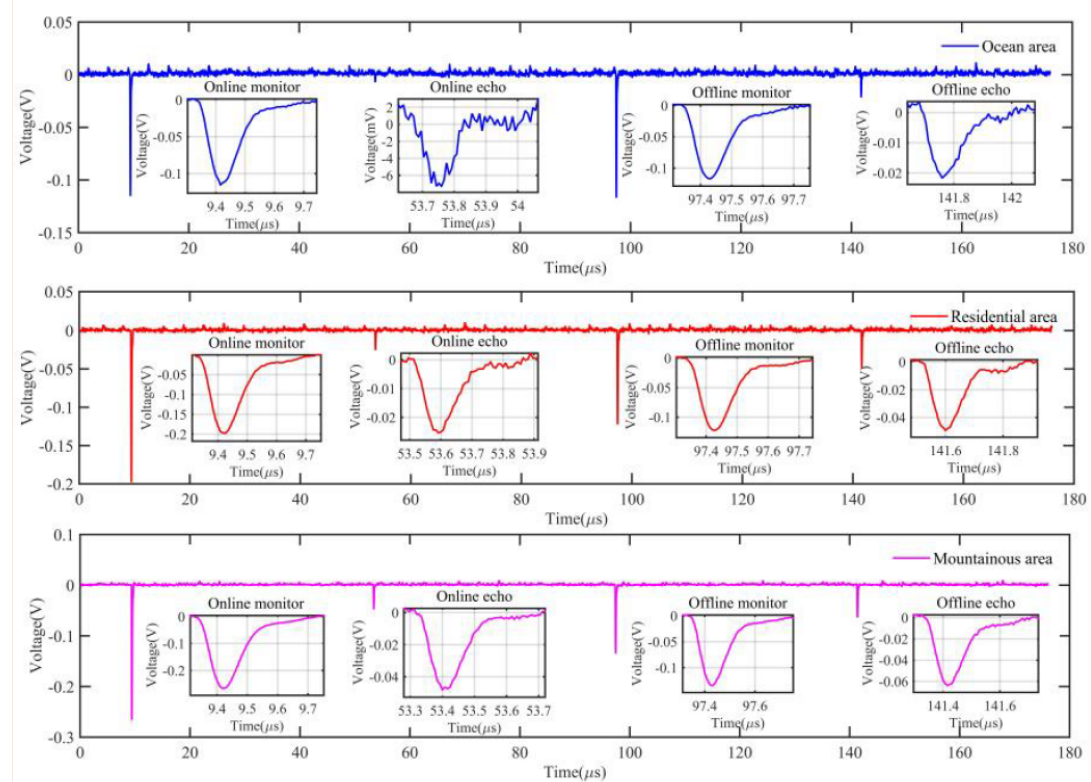
Figure 21. The echo signals of ocean, residential area and mountainous area received in airborne flight test in 2019 [20].